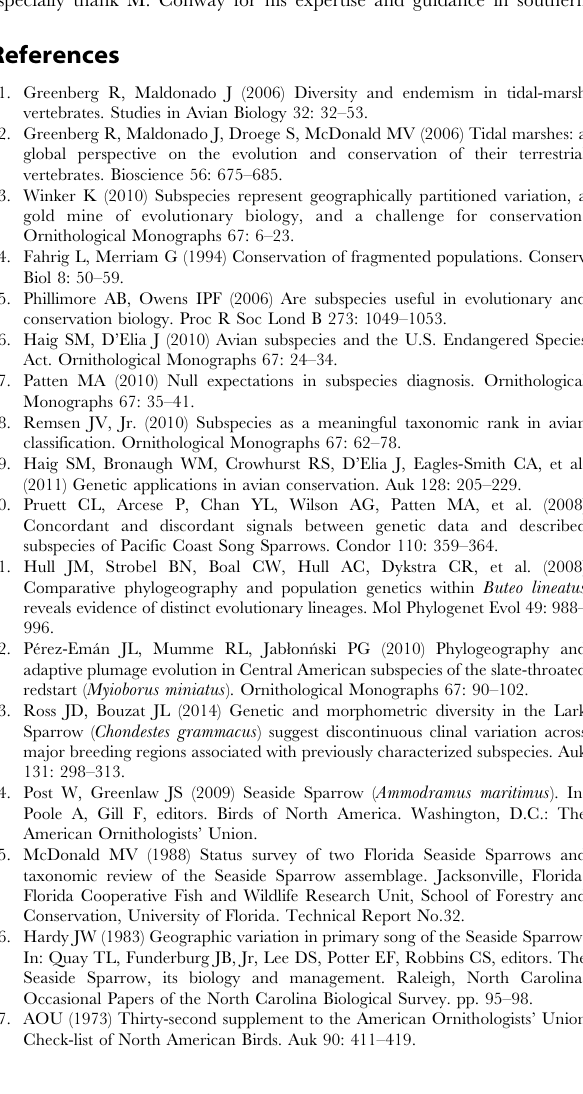
File S1 Figures S1 (showing plots of isolation by distance for microsatellite and mitochondria genotype data) and S2 (showing and ND2 haplotype network).